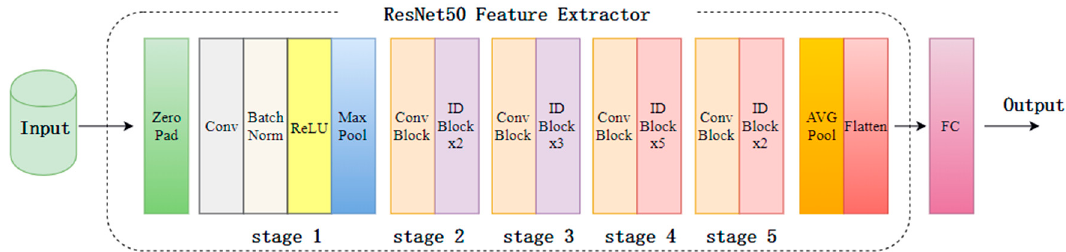
Figure 4. ResNet50 network structure.